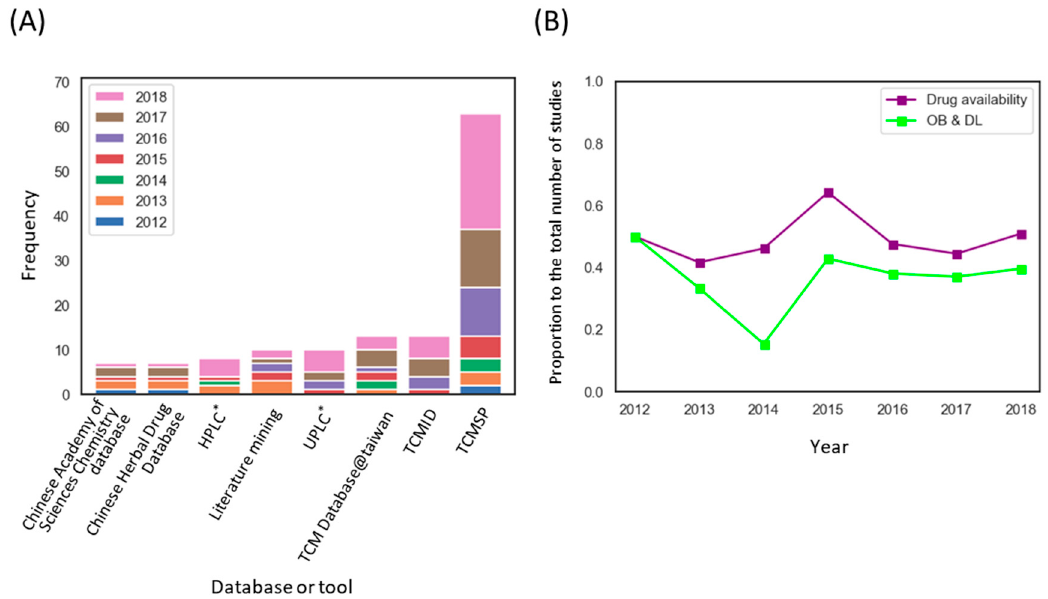
Figure 4. Methodological trends in the construction of the herb–compound network. ( A ) Frequency of databases and tools used to identify constituents of herbal medicine. * Analytical techniques to identify the ingredients of herbal medicines; Ultra Performance Liquid Chromatography (UPLC), High-performance liquid chromatography (HPLC) ( B ) The application rate of the drug availability method by year. Note that Obioavail (OB) and drug-likeness (DL) are among the most commonly used drug availability assessment methods in THM-NP studies. THM-NP studies in 2011 were excluded from the visualization due to the low frequency ( n = 2). TCMSP, Traditional Chinese Medicine Systems Pharmacology Database; TCMID, Traditional Chinese Medicine Integrated Database.